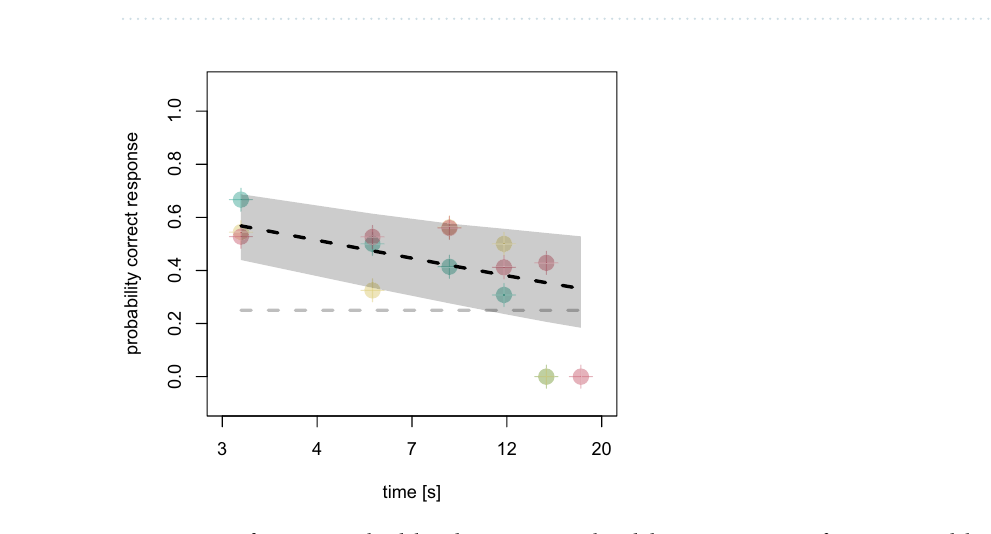
Figure 3. Performance in the double repeat trials. Gray density plots show the prior centered around chance- level (gray dashed line). Colored density plots show the posterior distributions for the average performance. Dashed colored lines are the means. Dots are outcomes per trial.